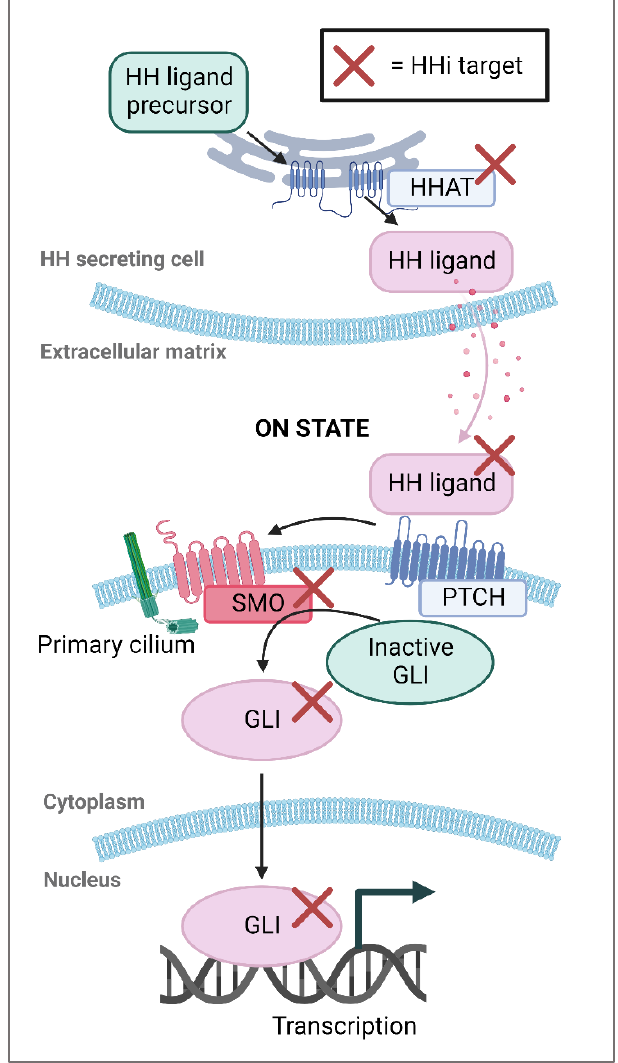
Figure 1. The main components of the hedgehog pathway. Membrane proteins are either blue or red, inactive proteins are green and active proteins are colored pink. The red crosses indicate target proteins for hedgehog inhibitors (HHis). In canonical hedgehog (HH) signaling, HH ligands are modified by hedgehog acyltransferase (HHAT) and released from HH-secreting cells. HH ligands then bind to the cell membrane protein patched (PTCH), which leads to release of smoothened (SMO). SMO moves to the primary cilium where it prevents breakdown of GLI family zinc finger proteins (GLI) allowing them to translocate to the nucleus and promote expression of HH-signaling target genes. In basal cell carcinomas (BCCs), inactivating PTCH1 mutations are most common (70–90%) followed by activating SMO mutations (10–20%). Created with